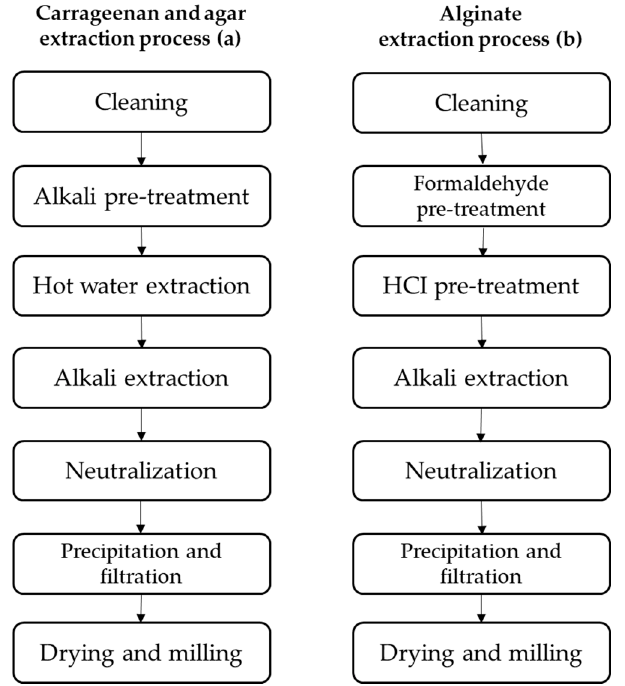
Figure 4. Common extraction process for commercial seaweed hydrocolloids: carrageenan and agar ( a ) and alginate ( b ).